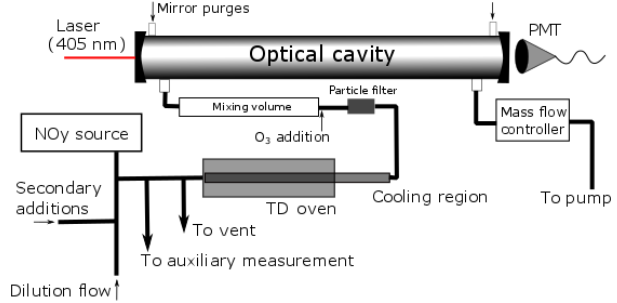
Figure 1. Instrument schematic of the TD-CRDS instrument used in this study. An NO y source (HNO 3 permeation tube, N 2 O 5 cold trap, NH 4 NO 3 particle atomizer + DMA size selector, or NH 3 per- meation tube) is diluted by a zero air flow (with an option for adding O 3 , VOCs, RH, or CO through the secondary addition port) and passed through the TD oven. A portion of the flow is sampled prior to entering the oven with one of several types of auxiliary mea- surements (CIMS for N 2 O 5 ; an ultra-high sensitivity aerosol spec- trometer, UHSAS, for NH 4 NO 3 particles; or commercial CRDS for NH 3 ) . After flowing through a cooling region, the sample passes through a particle filter and then is mixed with a ∼ 30ppmv addi- tion of O 3 in a mixing volume before entering through the optical cavity, where NO 2 is measured by